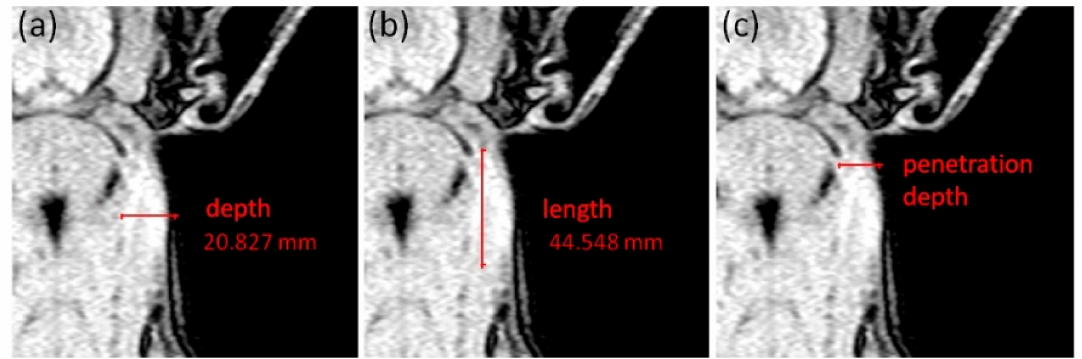
Figure 2. Description of the linear measurements at scan 1, showing a mild local reaction at the right neck side: ( a ) measurement of the maximum depth (mm) of local reaction site, ( b ) measurement of the maximum length (mm) of local reaction and ( c ) measurement of the penetration depth (mm) at the beginning of the signal increased region behind the